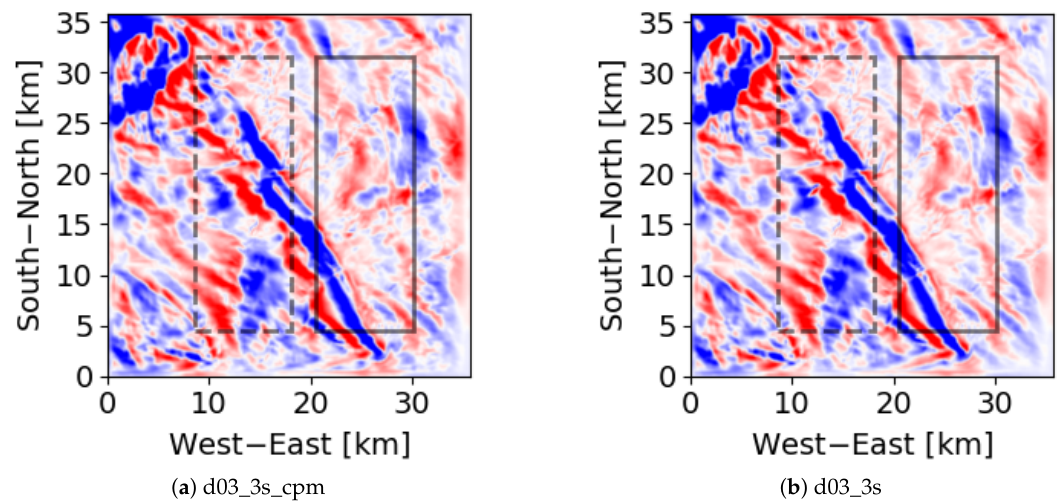
Figure 17. As in Figure 16b,c but for simulations with 3 arcsec topography